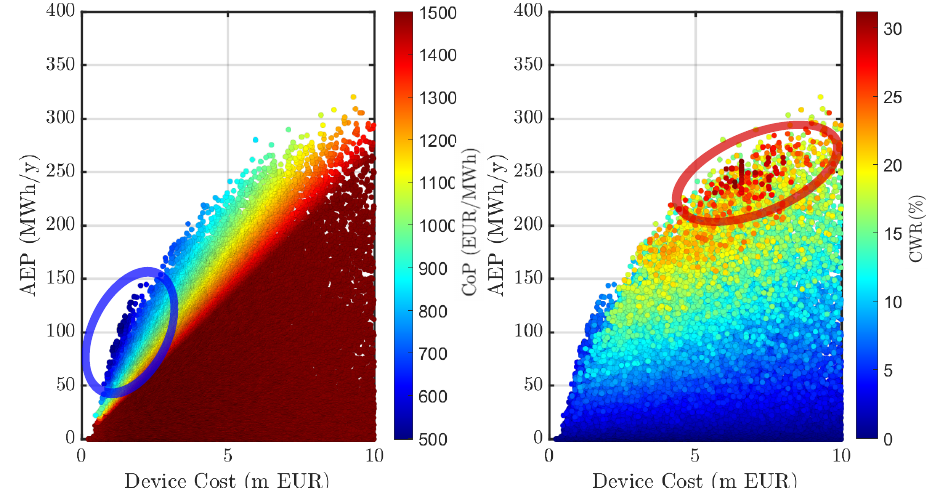
Figure 11. Productivity versus cost of the ensemble of the three optimisations aggregated; with each marker (individual), colour is proportional to the CoP (left) and capture width ratio (CWR) (right). The elliptical annotation highlight the most convenient region according to the evaluation metric (low CoP and high